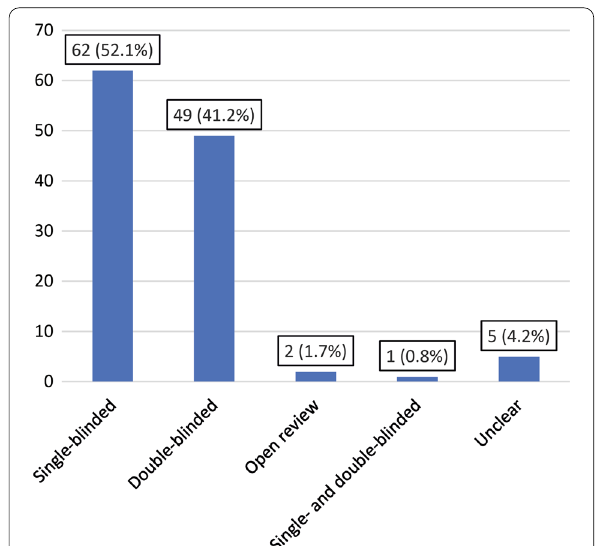
Fig. 1 Peer review models used by 119 medical imaging journals (absolute numbers of journals with percentages